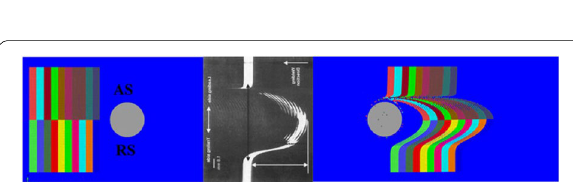
Figure 24 Simulation results for the model: ( a ) contours of velocity magnitude (m/s); ( b ) velocity vectors; ( c ) strain rate; ( d ) temperature contours [27]